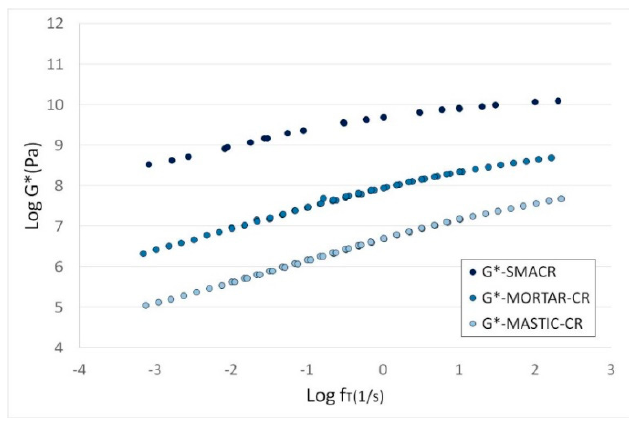
Figure 9. SMACR, MORTAR-CR and MASTIC-CR master curves.